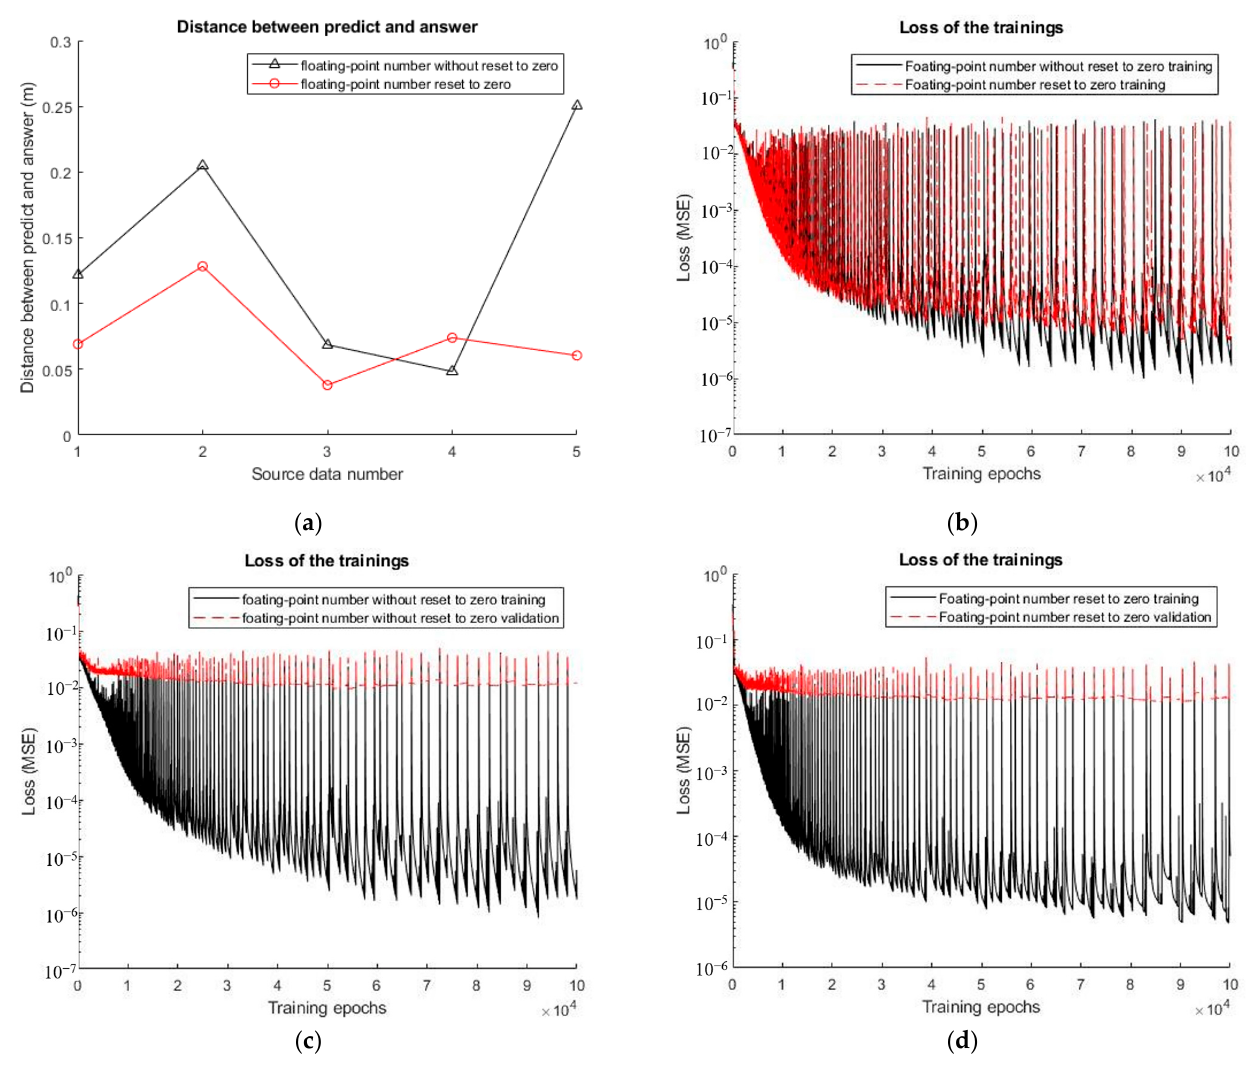
Figure 10. ( a ) Prediction errors obtained before and after floating-point number preprocessing. ( b ) Training epochs obtained before and after the “floating-point number” process. ( c ) Verification training epoch obtained before floating-point number preprocessing. ( d ) Verification training epoch obtained after floating-point number preprocessing.